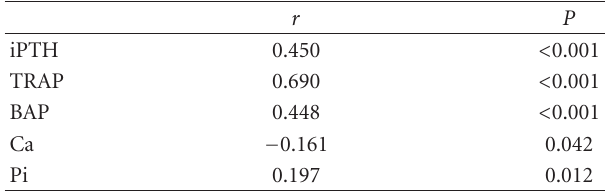
Table 2: Associations between the cross-linked N-telopeptide of type I collagen and other parameters of bone resorption (measure- ments obtained at various times were